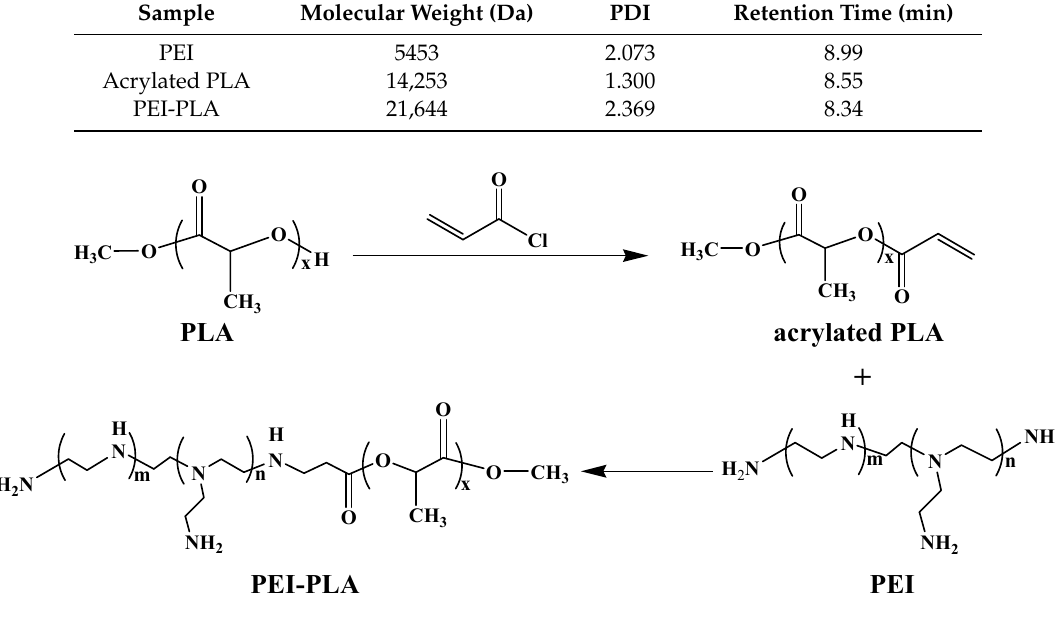
Figure 1. Synthetic scheme of PEI-PLA copolymer.